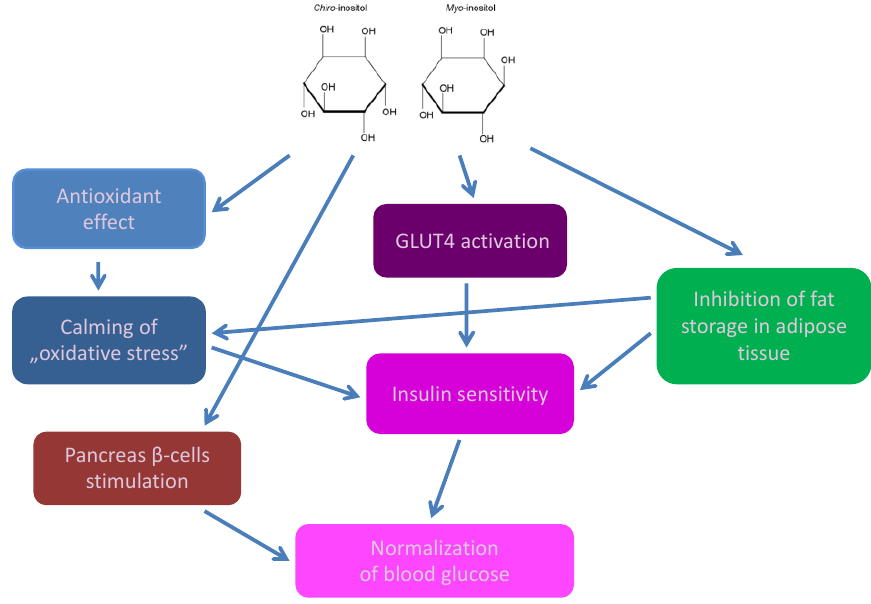
Figure 4. The action of cyclitols in diabetes mellitus.